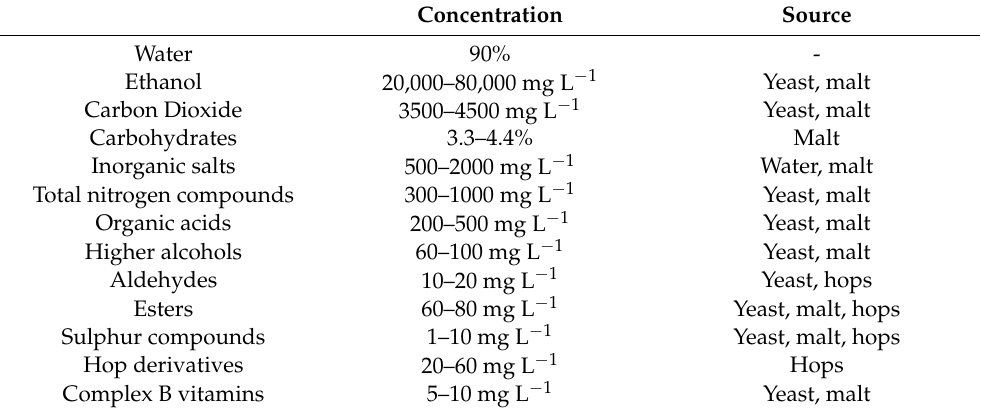
Table 1. Chemical composition of regular beer (information provided in the literature